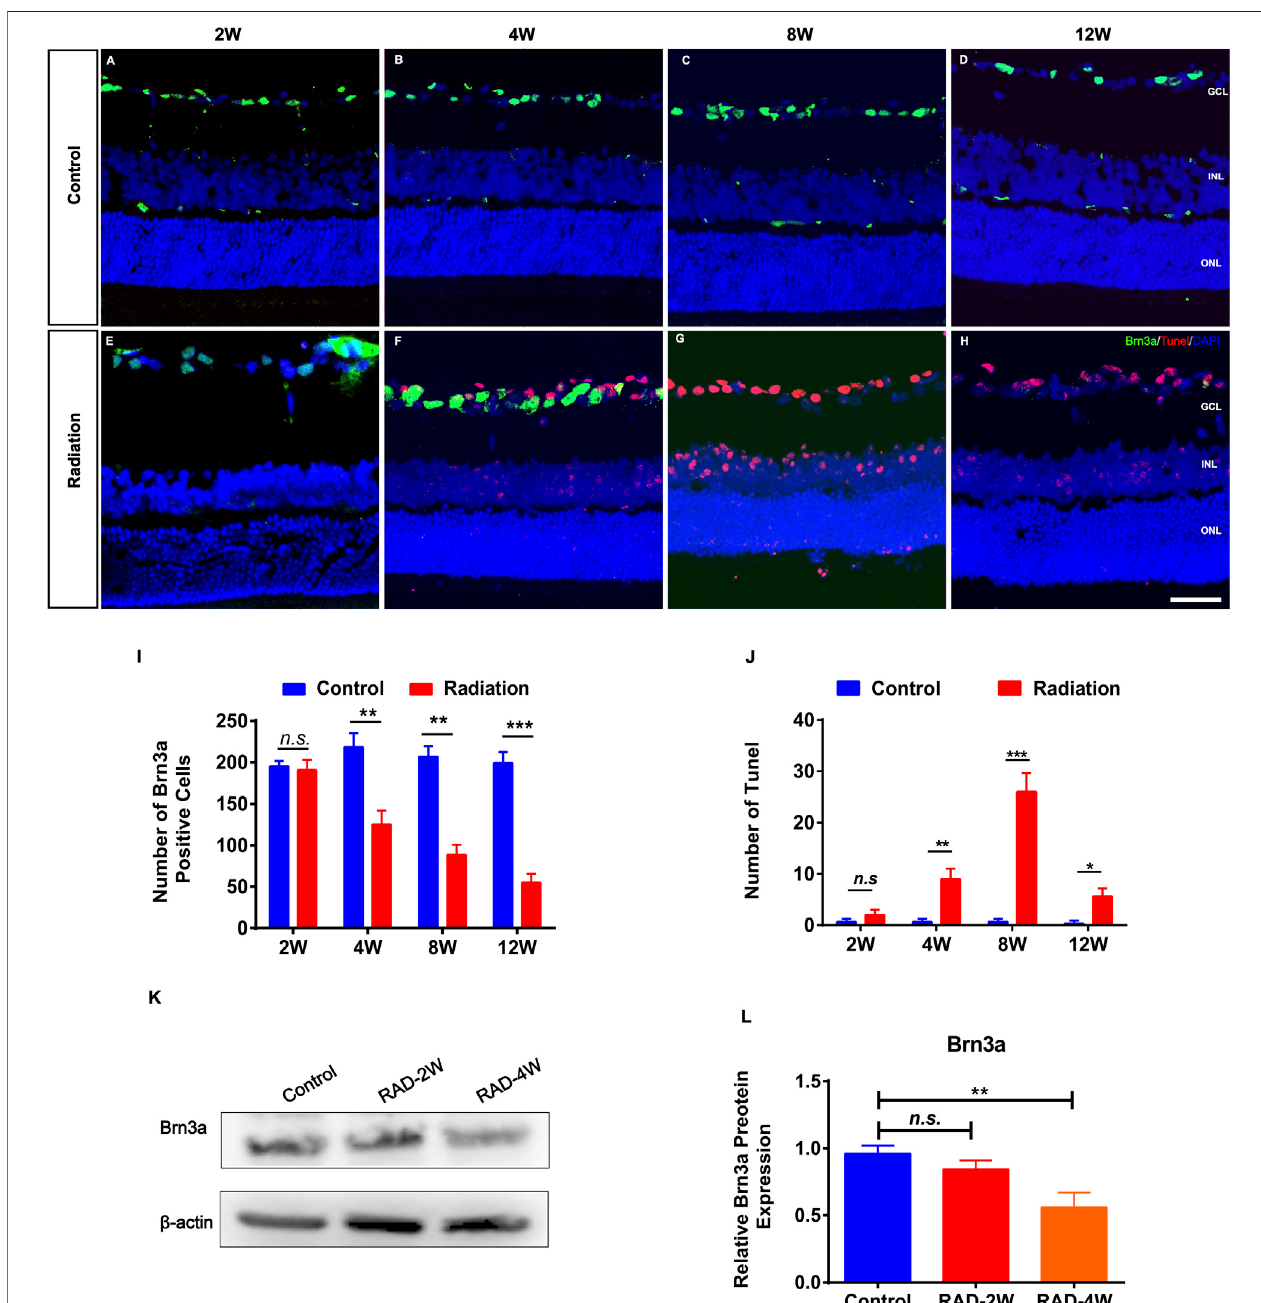
FIGURE 2 | The apoptosis of retinal ganglion cells in irradiated LE rats. (A – H) : Representative images of Brn3a + ganglion cells (Green) and apoptotic cells (Red) in controland irradiatedratretinaafter2,4,8,and12 weeksradiation.Scalebar:50 μ m. (I,J) :ThenumberofBrn3a + and Tunelpositivecellsintheretina. (K) :WBanalysis of the protein expression of Brn3a inthe retina. (L) : The statisticsof WB grayscaleof Brn3a protein expression. N = 3. Dataare depicted as means ± SEM. (* p < 0.05, ** p < 0.01, *** p < 0.001). GCL: ganglion cell layer; INL: inner nuclear layer; ONL: outer nuclear layer.